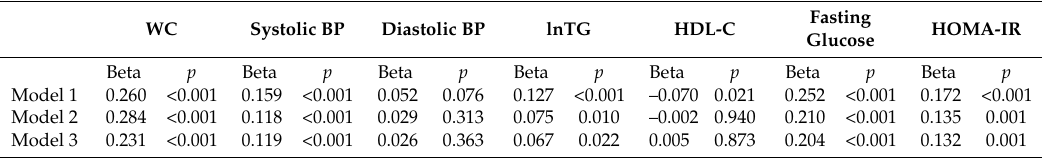
Table 3. Linear regression models showing standardized betas with serum selenium concentrations as independent variable for metabolic factors.